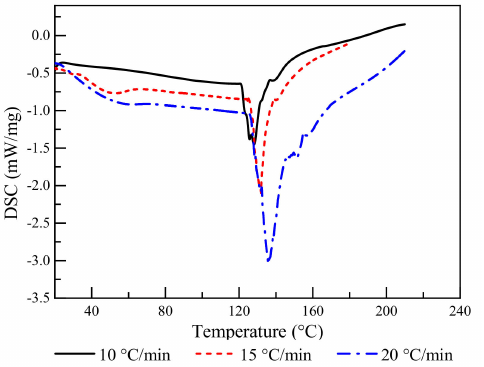
Figure 2. DSC curve of thermosetting BPF resin at different heating rates.